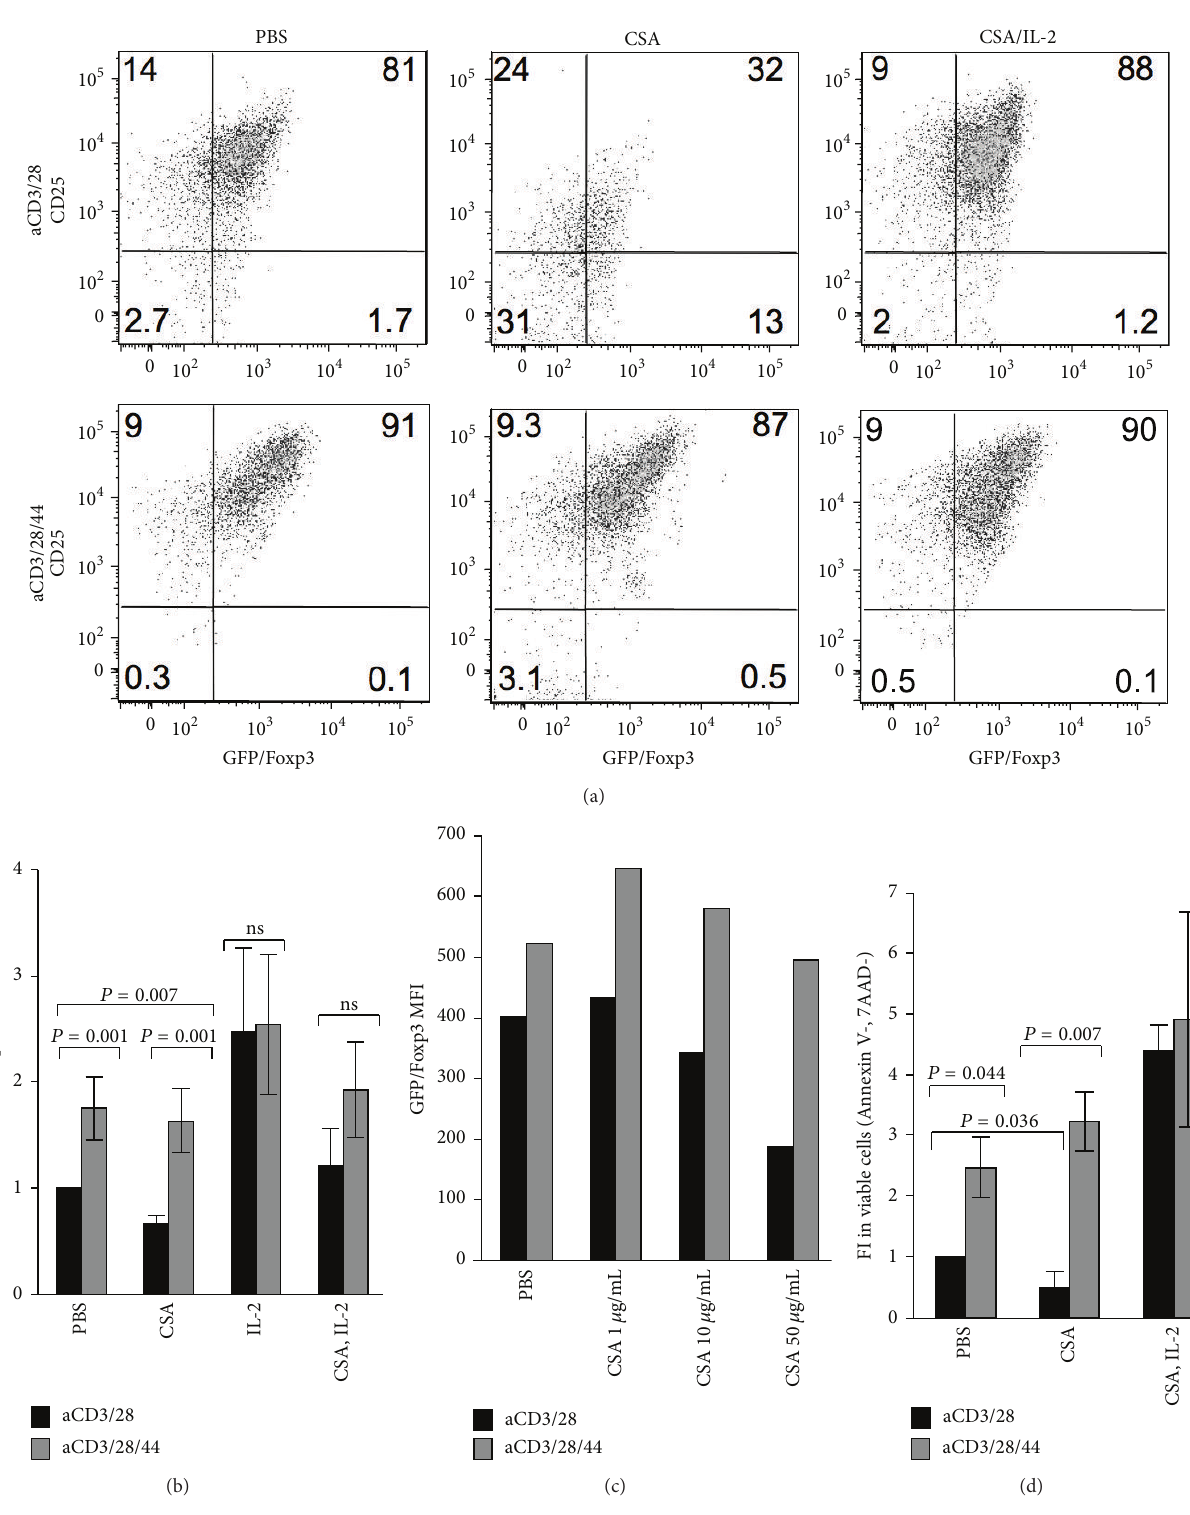
Figure 2: CD44 cross-linking and IL-2 both promote Foxp3 expression and Treg persistence despite CSA treatment. (a) Representative flow cytometric analysis of CD25 labeled and GFP/Foxp3+ cells after 3 days in culture in the presence of anti-CD3 and anti-CD28 alone or with the addition of anti-CD44, and with or without CSA (50ng/mL) alone or together with IL-2 (20IU/mL). (b) Fold increase (FI) in GFP/Foxp3 MFI after 3 days of culture in the presence of anti-CD3 and anti-CD28 alone or in conjunction with anti-CD44 Ab, with or without CSA (50 ng/mL) alone or together with IL-2 (20 IU/mL). 𝑁 = 4 independent experiments, among these are included Figure 2(a). (c) Fold Increase in GFP/FoxP3 MFI in the presence of anti-CD3 and anti-CD28 alone, or in conjunction with anti-CD44 and increasing concentrations of CSA. Data are representative of two experiments. (d) Fold increase in the fraction of viable GFP/FoxP3+ cells (Annexin V-, 7AAD-) upon culture with aCD3/28 or aCD3/28/44 with or without CSA (50 ng/mL) alone or together with IL-2 (20 IU/mL). 𝑁 = 4 experiments among these are included in Figure 2(a) and the other experiments are in Figure